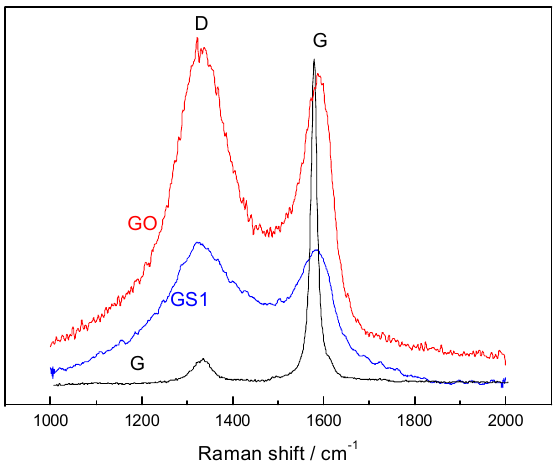
Figure 4. The Raman spectra of G, GO, and GS1.